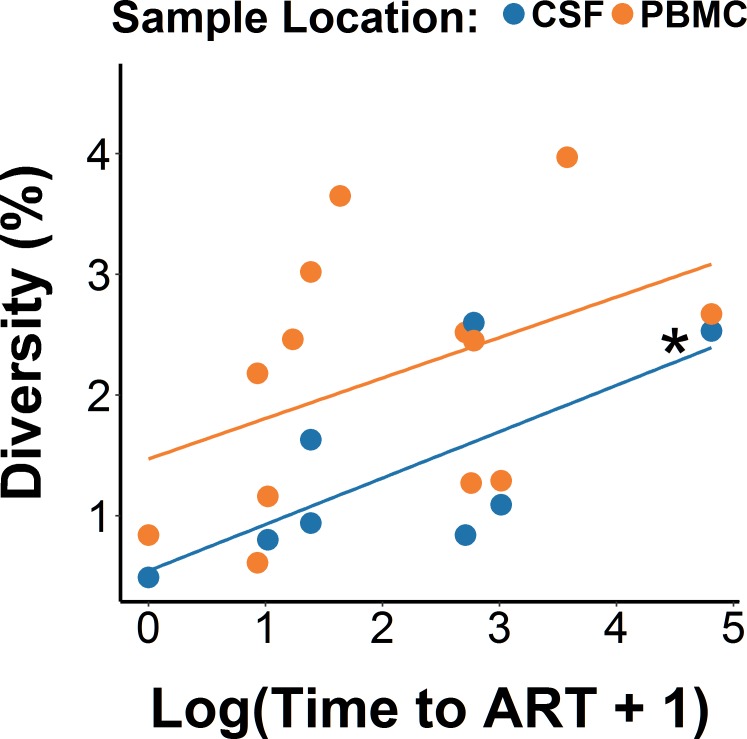
Regression analysis between time to ART start and HIV DNA molecular diversity in blood and CSF.Linear mixed-effects regression models revealing the relationship between molecular diversity of HIV DNA env with log-transformed time to ART start. *p = 0.05 for the correlation within CSF.